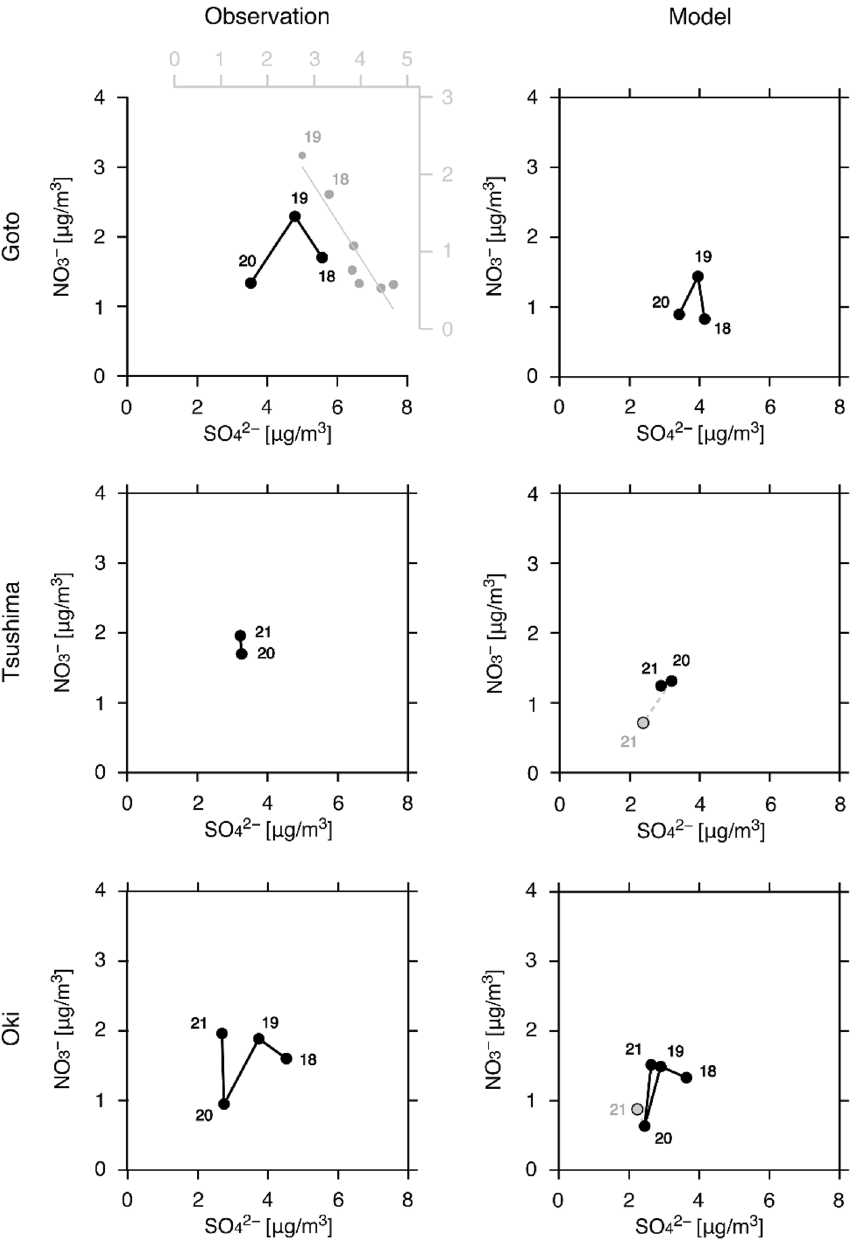
Figure 5. (Left) Observed and (right) modelled scatterplots of SO 42− and NO 3− at (top) Goto, (middle) Tsushima and (bottom) Oki averaged over two months (February and March). The number near each circle indicates the year (i.e., ‘18’ means 2018). At Goto, the results from a previous study 4 are shown in grey. The previous study analysed PM 1 components, whereas the present study analysed PM 2.5 components. For the model results, those of experiment M21E20 are shown by the grey closed